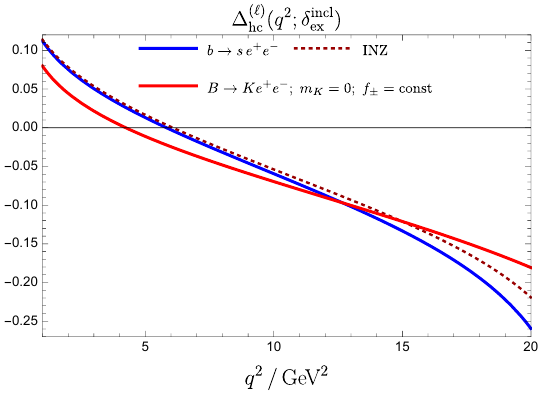
Figure 8 . Comparison of hard-collinear logs in b → se + e − (solid blue line) versus ¯ B → ¯ Ke + e − ( γ ) with no photon energy cut, constant form factors and m K → 0 (solid red line) corresponding to eqs. (A.7). This illustrates the spin-dependance of the hard-collinear which can be traced back to the LO differential rates in the case at hand cf. (A.6). For further comparison, we have added the full result in the dotted red line for this paper with no photon energy cut either. The agreement at low q 2 of the latter with the b → se + e − is somewhat